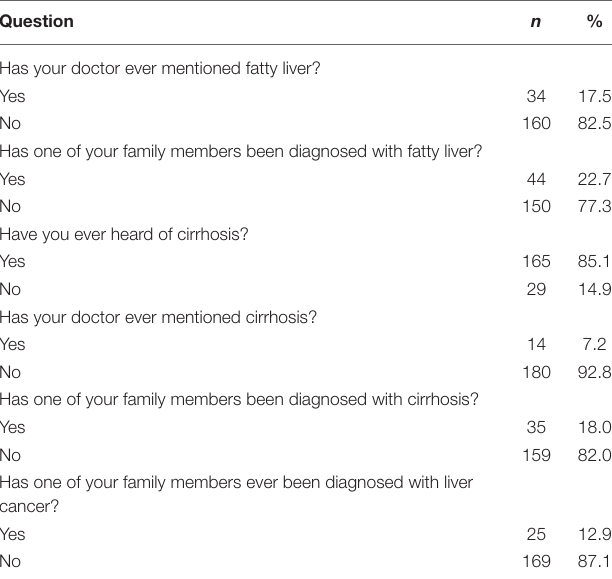
TABLE 2 | Participant responses to nonalcoholic fatty liver disease awareness and related conditions questionnaire ( n =